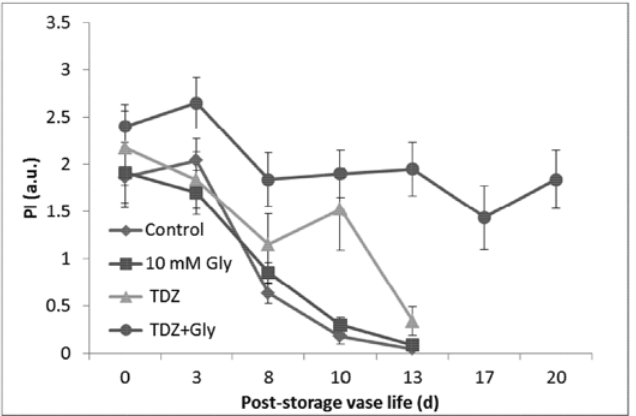
Fig. 6 - Sucrose content measured in leaves of stored cut Danae branch- es treated with distilled water (control), 10 µM TDZ or 10 µM TDZ plus 10 mM Glycerol during vase life. Values are means with standard errors ( n